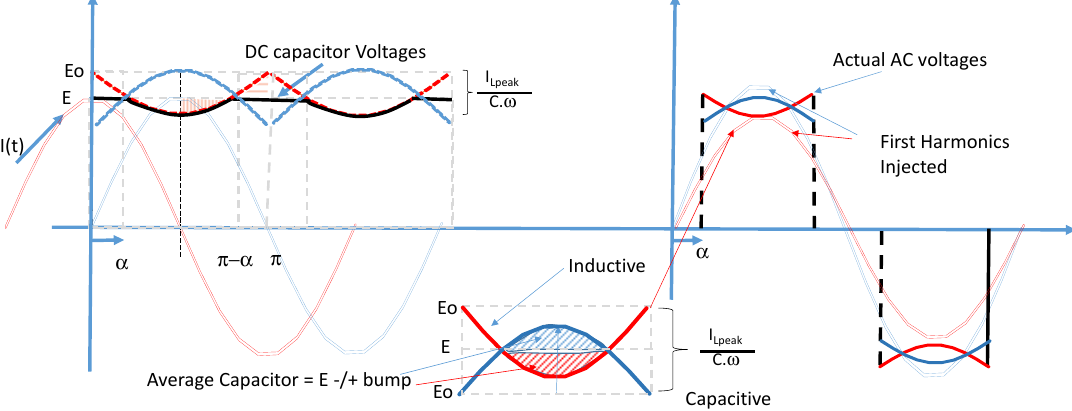
Figure 7. Concave or convex shape of the voltage depending on inductive or capacitive mode.